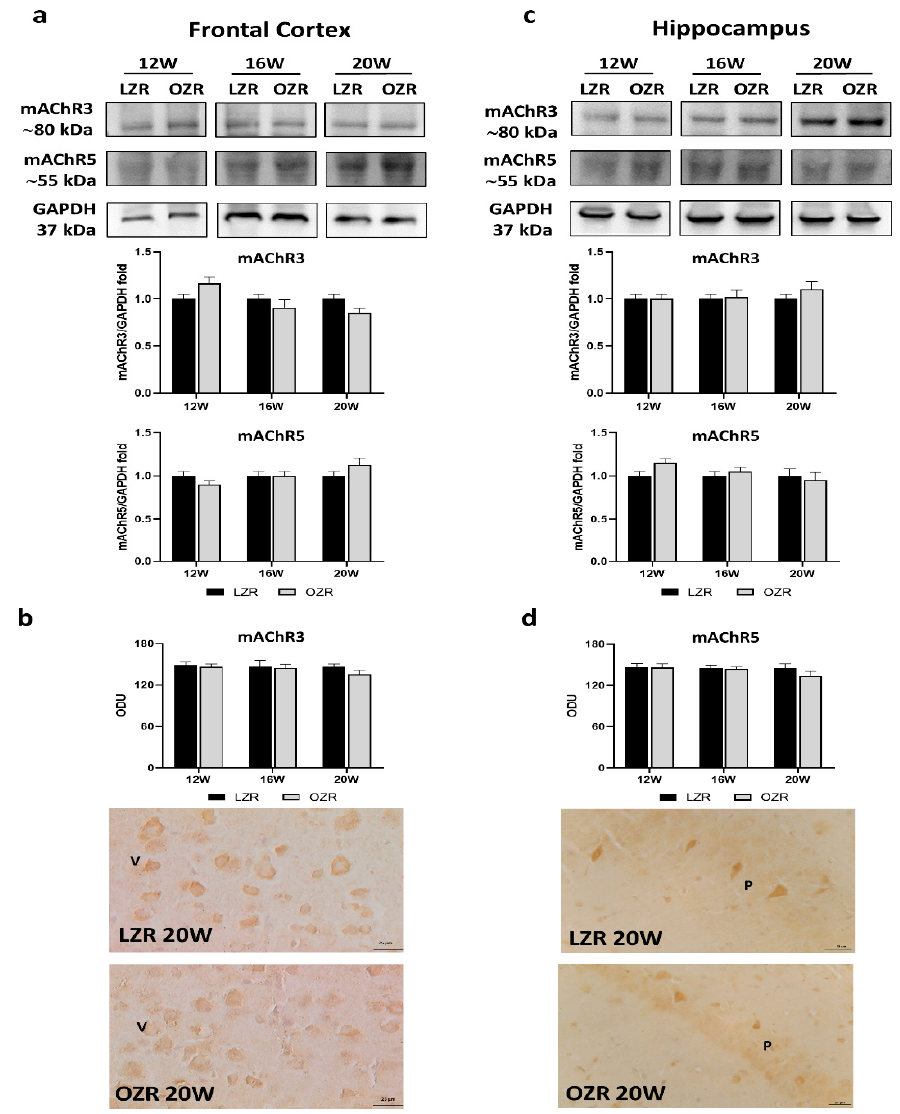
Figure 4. Immunoblotting and immunoreaction of muscarinic acetylcholine receptor subtype 3 (mAChR3) and muscarinic acetylcholine receptor subtype 5 (mAChR5). Lysates of the frontal cortex ( a ) and hippocampus ( c ) from lean Zucker rats (LZRs) and obese Zucker rats (OZRs) at the age of 12, 16, and 20 weeks were immunoblotted using specific anti-mAChR3 and anti-mAChR5. Bar graphs indicate the densitometric analysis using LZRs as control, and GAPDH levels were used as a loading control. Blots are representative of one of three separate experiments; intensity values of mAChR3 immunostaining in the frontal cortex ( b ) and mAChR5 in the hippocampus ( d ) from LZRs and OZRs at the age of 12, 16, and 20 weeks measured in optical density units (ODUs). Data are mean ± S.E.M. Representative pictures of 20-week-old LZRs and OZRs in frontal cortex for mAChR3 ( b ) and hippocampus for mAChR5 ( d ). V: the fifth layer of the frontal cortex. P: pyramidal neurons of the hippocampus. 40× magnification. Calibration bar: 25 µm.